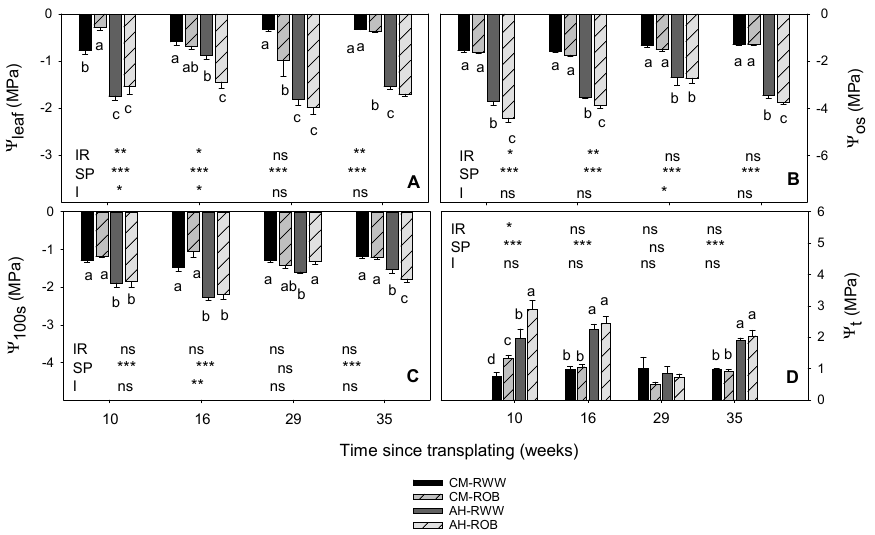
Figure 1. Leaf water potential ( Ψ leaf ) ( A ), osmotic water potential ( Ψ os ) ( B ), osmotic water potential at full turgor ( Ψ 100s ) ( C ) and leaf turgor potential ( Ψ t ) ( D ) in Crithmum maritimum (CM) and Atriplex halimus (AH), irrigated with reclaimed wastewater (RWW) and reverse osmosis brine (ROB). Results were from one way and two-way ANOVA tests in these parameters, for independent variables (irrigation, IR, and species, SP) and their interaction (I). Different lowercase letters indicate significant differences between treatments according to Duncan’s test at p ≤ 0.05. * p < 0.05, ** p < 0.01 and *** p < 0.001. p > 0.05 non-significant differences are indicated by “ns”.